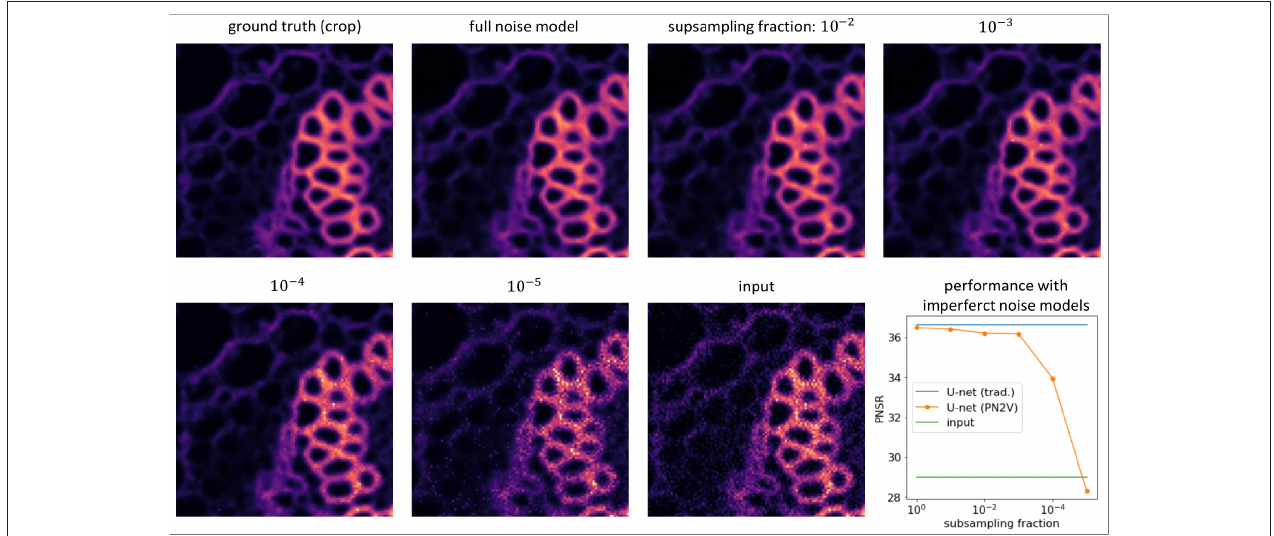
FIGURE 4 | Importance of good noise models. Images show a representative crop of the Convallaria data we describe in the main text. From top left to bottom right we show the ground-truth, a PN2V prediction using all available calibration data, four PN2V results on increasingly sub-sampled calibration data (see main text for details), and the corresponding noisy input crop. The plot shows the quality of PN2V denoising (PSNR) on full and increasingly sub-sampled noise models (orange), the PSNR of a traditionally trained U-Net (blue), and the PSNR of the noisy input (green). Interestingly, When a noise model is derived from too little calibration data, PSNR values decrease dramatically, even below the quality of the noisy input data. Still, for sufficiently large fractions, PN2V almost reaches the performance of traditional supervised training, despite never having seen a single ground-truth pixel.